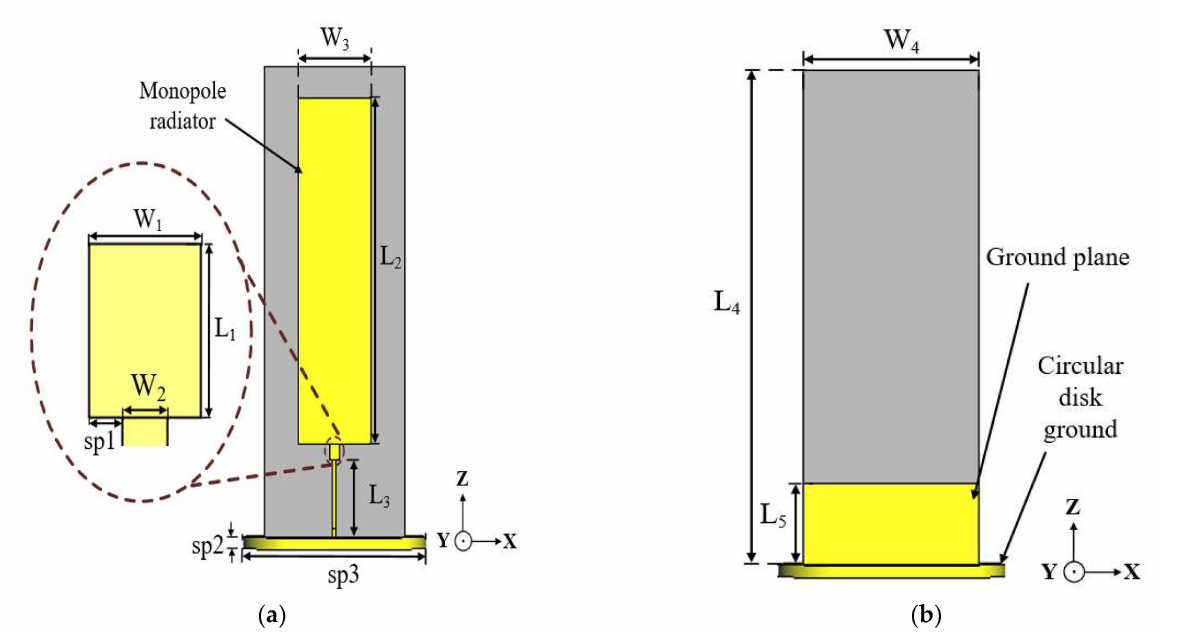
Figure 2. Geometry of the conventional monopole antenna: ( a ) front view and ( b ) back view.